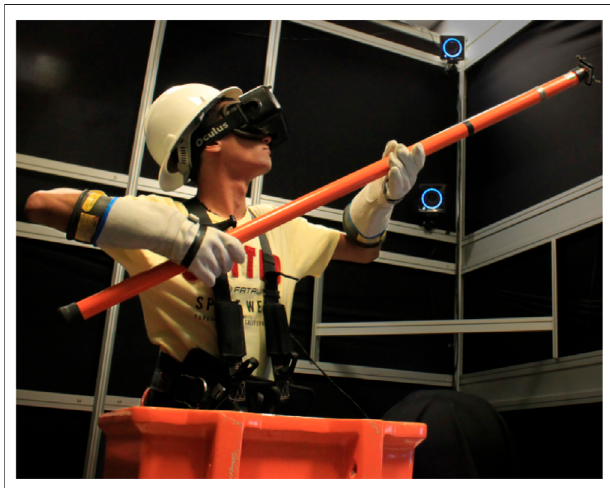
FIGURE 9 | A user learning power line operation and maintenance skills in VR. Image courtesy of Borba et al. (2016).